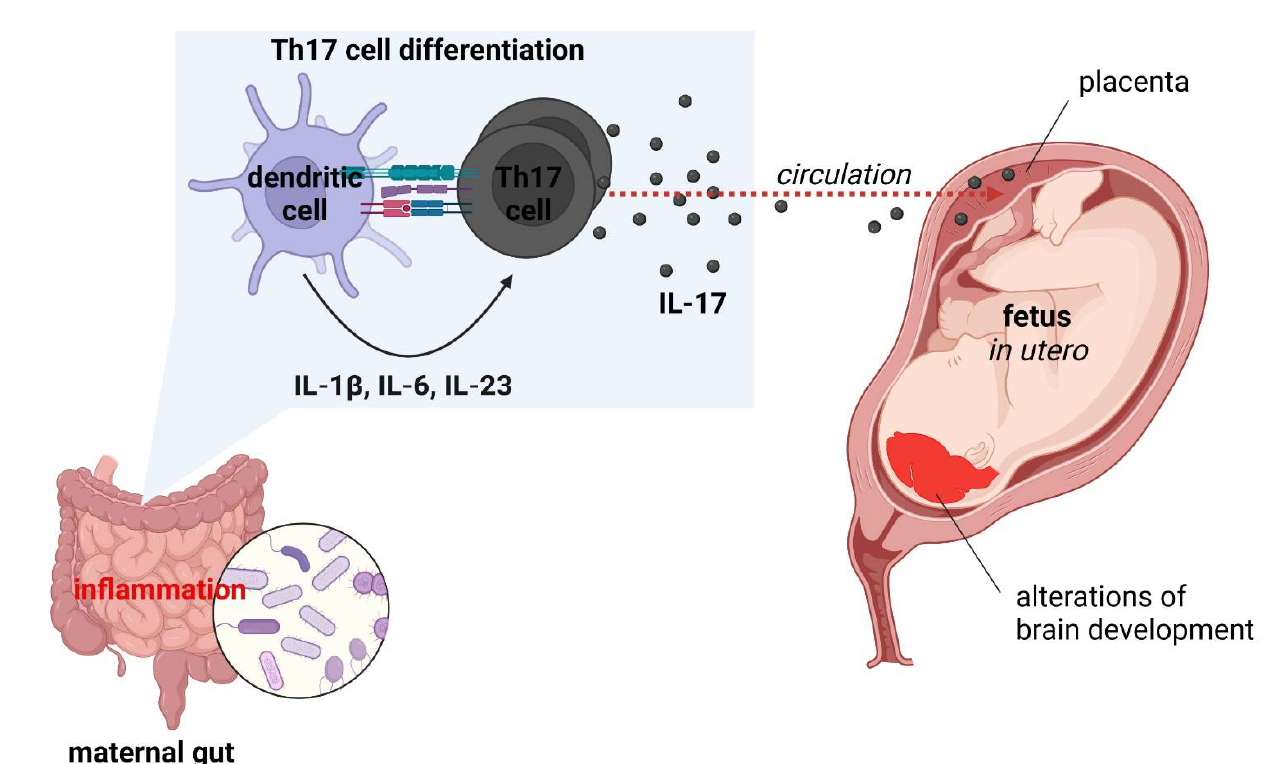
Figure 4. Maternal immune activation (MIA) model of autism spectrum disorder (ASD) development [own drawing]. Abbreviations: IL—interleukin; Th—T helper.